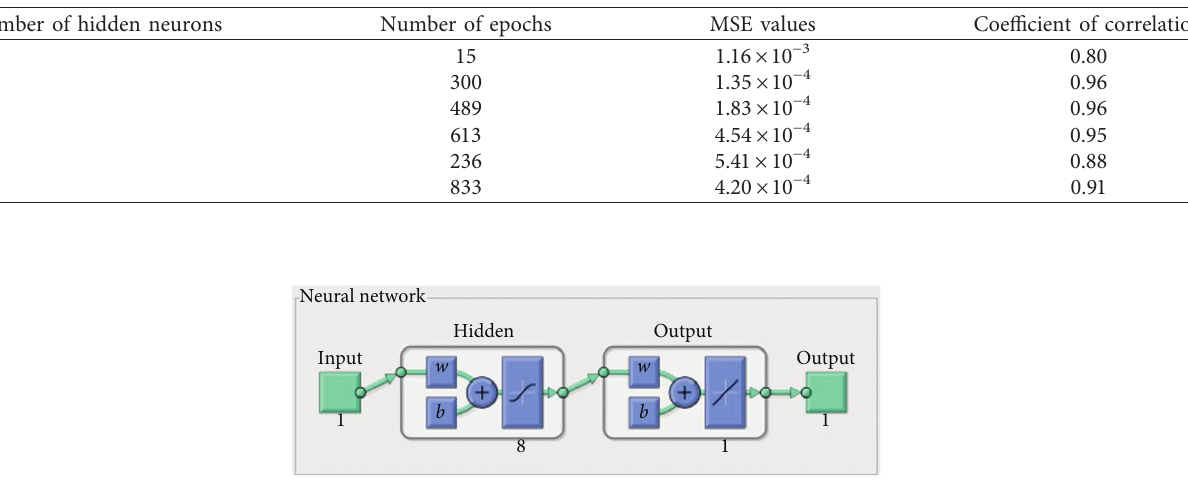
Table 3: Performance of the NN with variation in the number of the hidden neurons.